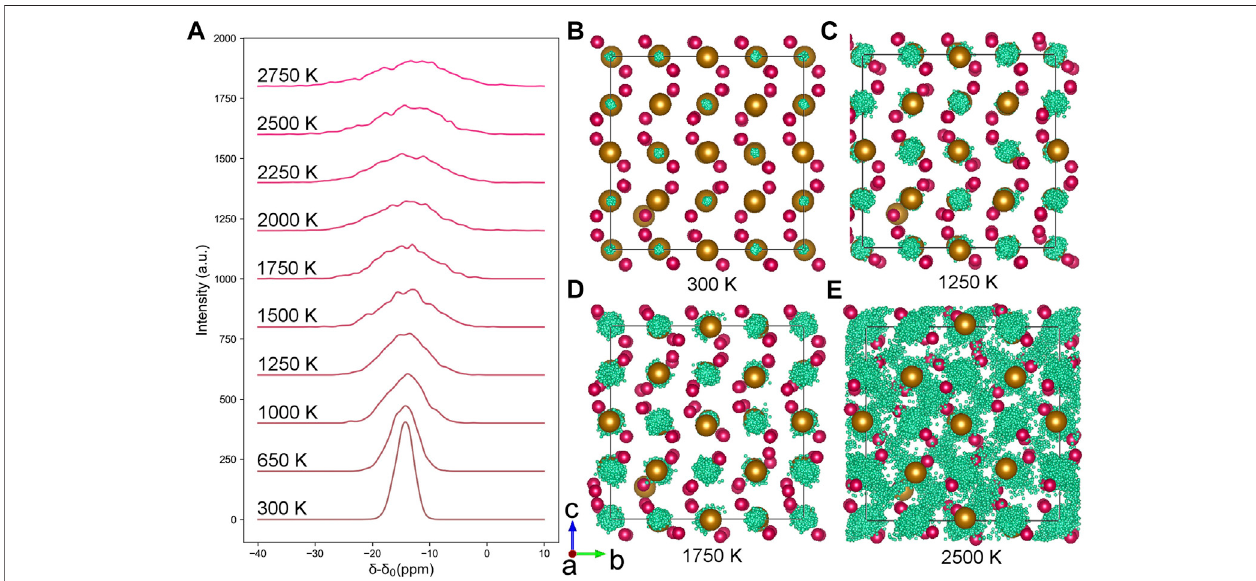
FIGURE1| EvolutionofNMRspectroscopyandtheircorrespondingstructures. (A). CalculatedNMRspectroscopyat100 GPaandupto2750 K. (B – E) Selected structures at 300, 1250, 1750, and 2,500 K. Hydrogen diffusion increases substantially at higher temperatures.